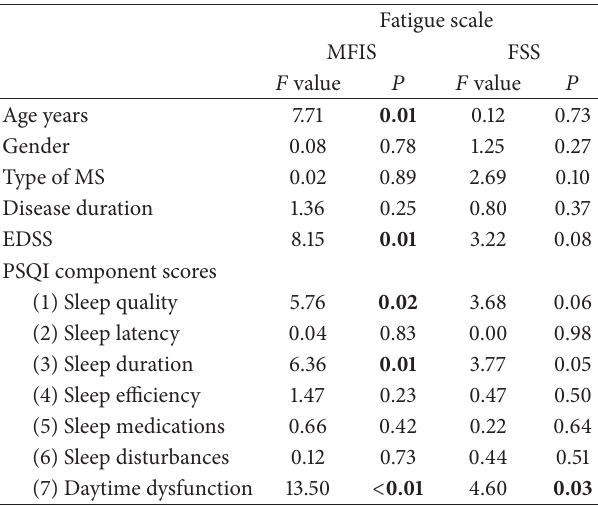
Table 3: Associations between fatigue (MFIS and FSS scores), sleep quality components (PSQI component scores), and demographic